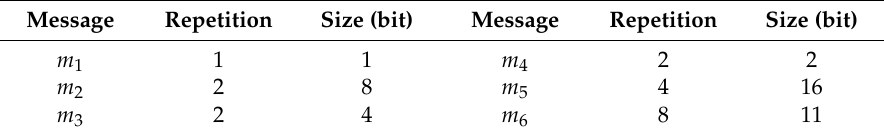
Table 2. Messages required for sending of an ECU (Electronic Control Unit).